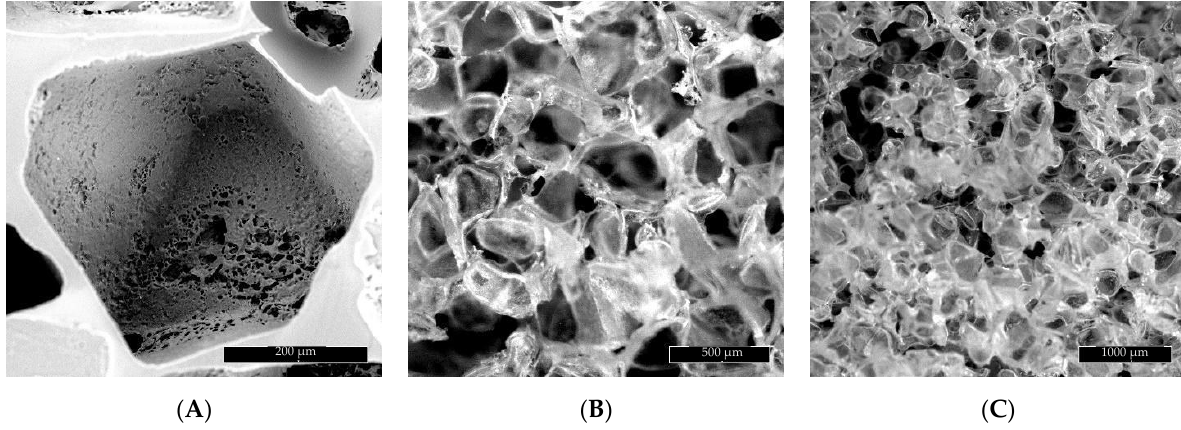
Figure 1. ( A ) SEM images of the PGS scaffold pores. ( B ) Optical image of the PGS scaffold. ( C ) Optical image of the PGS scaffold.